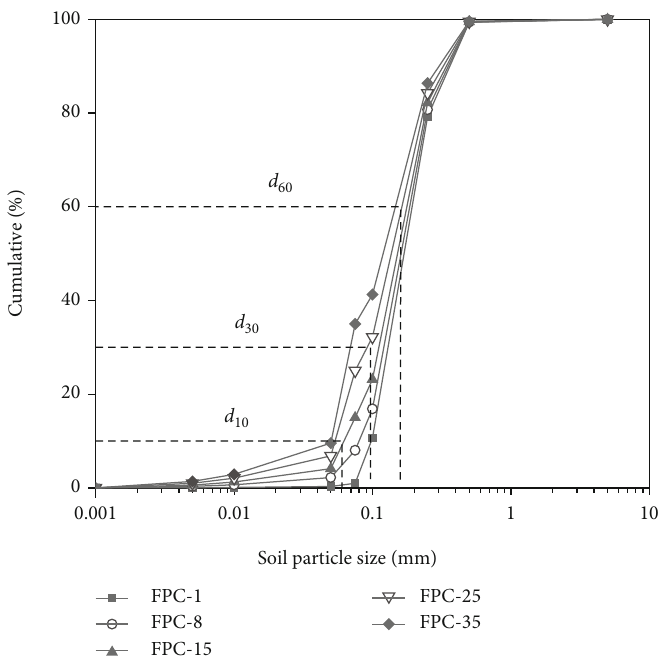
Figure 2: Particle sized distribution curves of silty sand with di ff erent silty particle content.